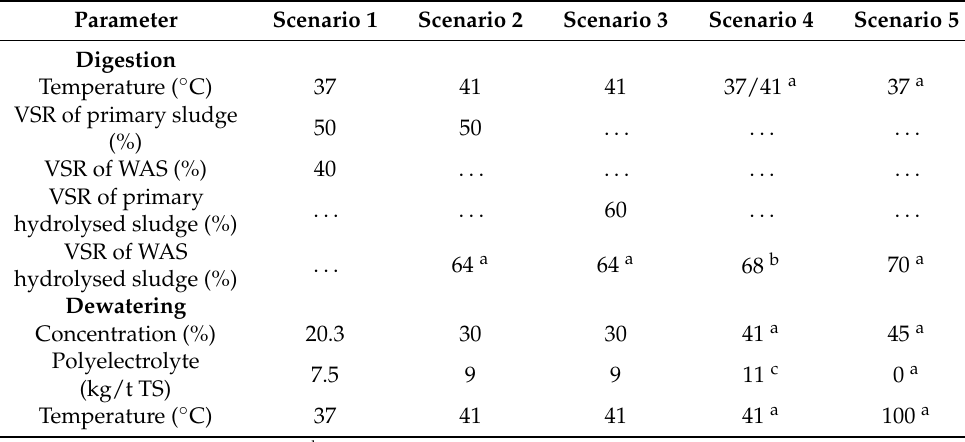
Table 4. Specific parameters of the WWTP for each scenario